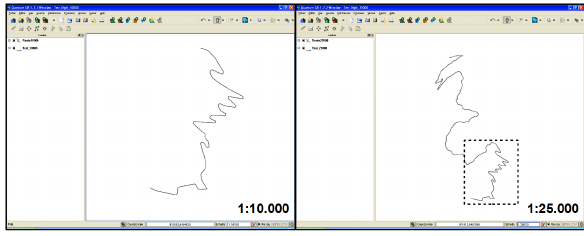
Figure 5. A same road represented at two different scales in the digitizing test experiment